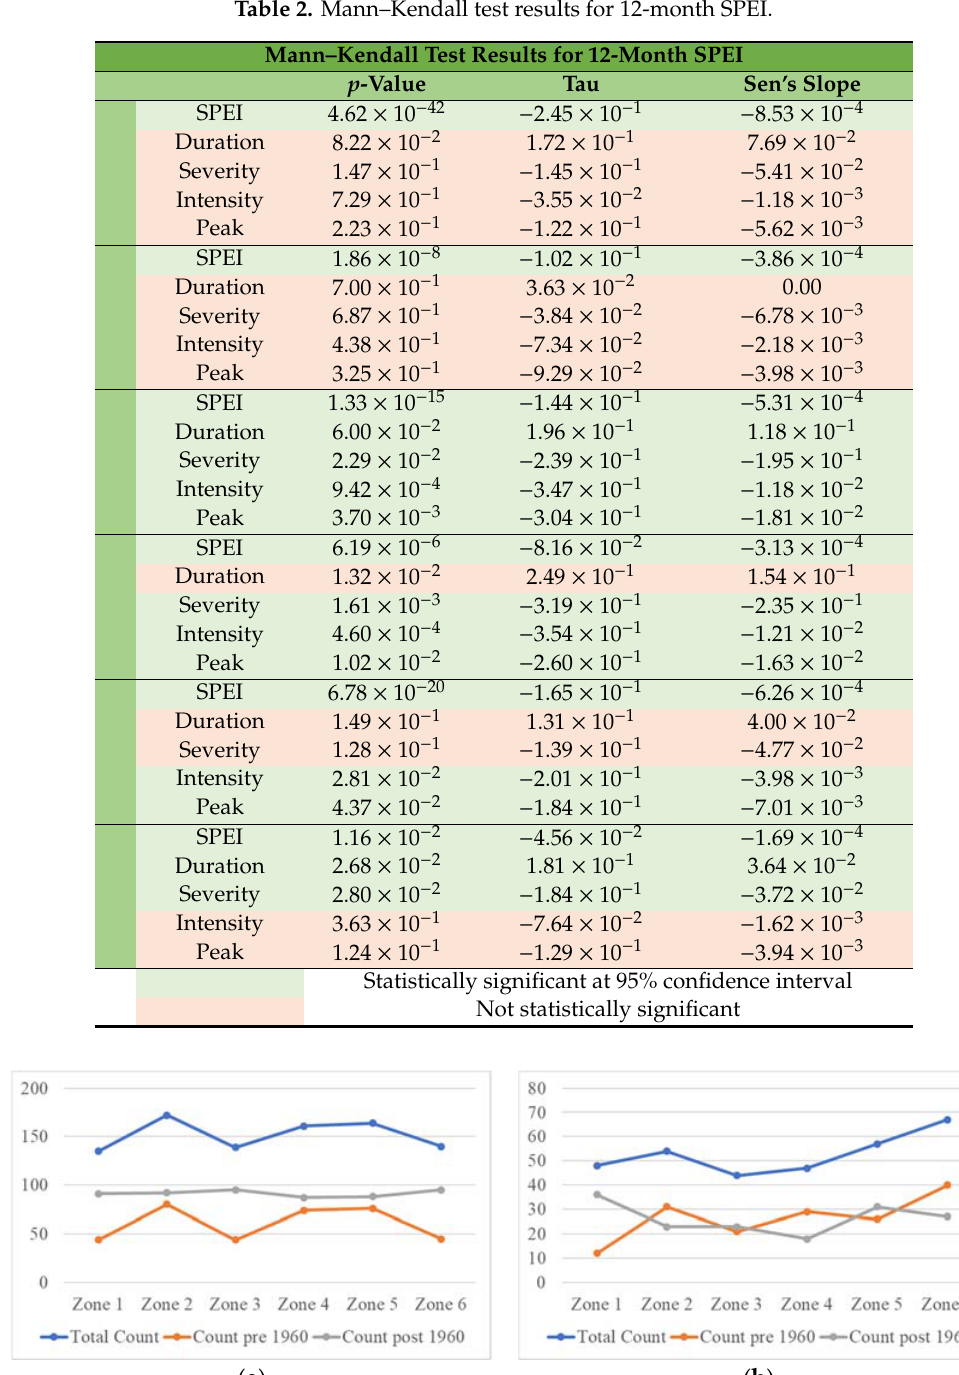
( b ) Figure 16. ( a ) 3 ‐ month and ( b ) 12 ‐ month SPEI maximum drought duration. ( a ) ( b ) Figure 17. ( a ) 3 ‐ month and ( b ) 12 ‐ month SPEI minimum drought severity. ( a )